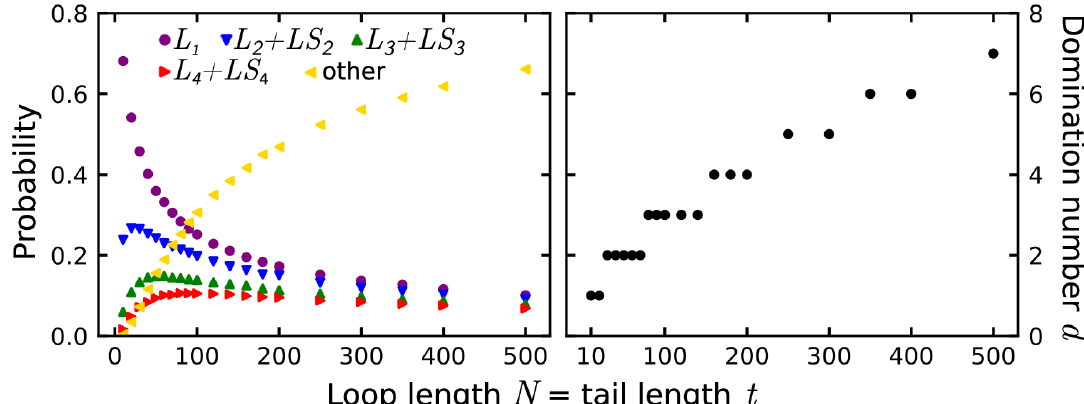
Figure 4. Analysis of non-trivial lassos. ( Left panel ) The probability for a given number of piercings as a function of the loop size for an equal loop size N and tail length t for non-trivial lassos only. “Other” means lassos with ≥ 5 piercings.; ( Right panel ) The domination number d as a function of the loop length N and tail length t = N for non-trivial lassos. The domination number d is a maximal number of piercings p for which lassos with ≥ p piercings are the majority of non-trivial lassos with given N and t (Equation